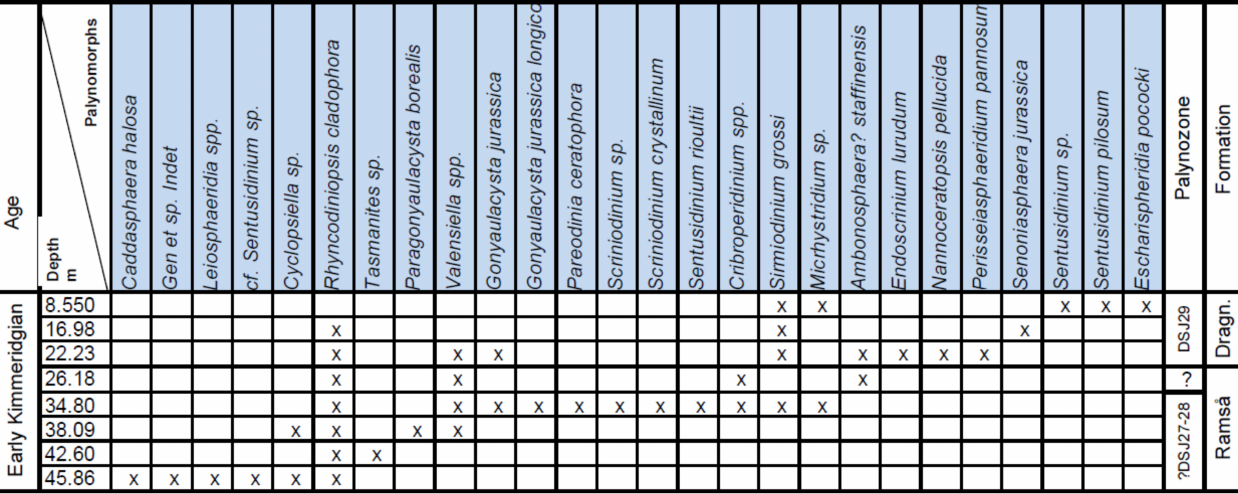
Figure A2. Records of marine palynomorphs in borehole Bh